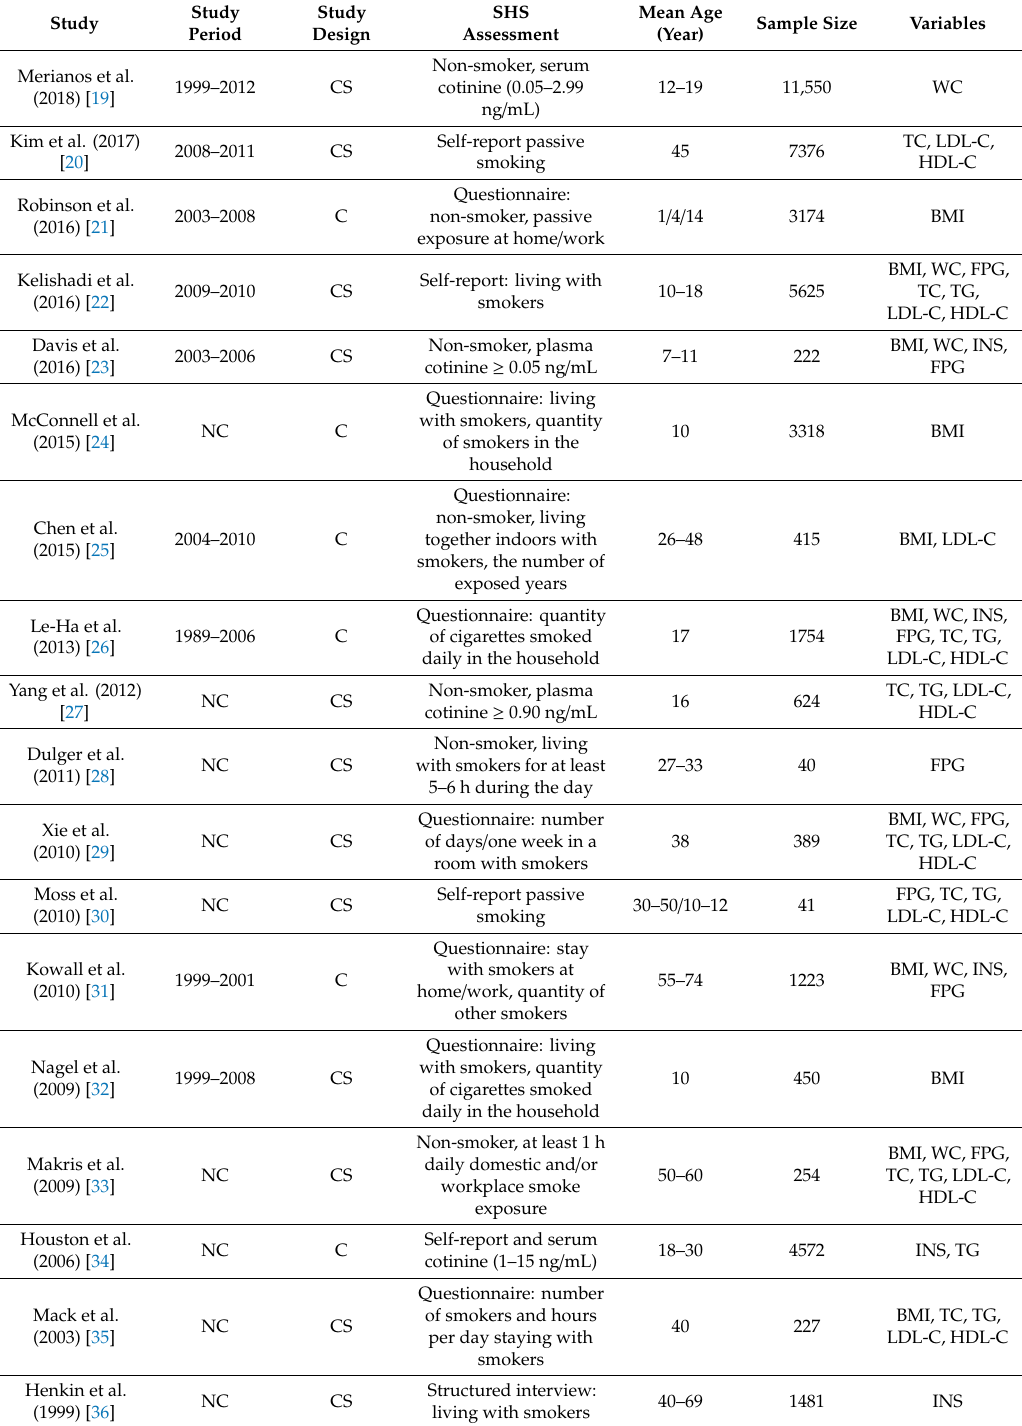
Table 1. Characteristics of included